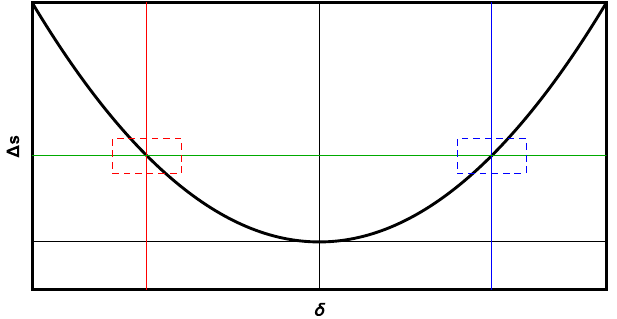
FIG. 12. Arc path length as a function of relative momentum deviation with only second order longitudinal dispersion non- zero. Red and blue displaced axes highlight the path length dependence on momentum for off-momentum beams with an effective nonzero R 56 .